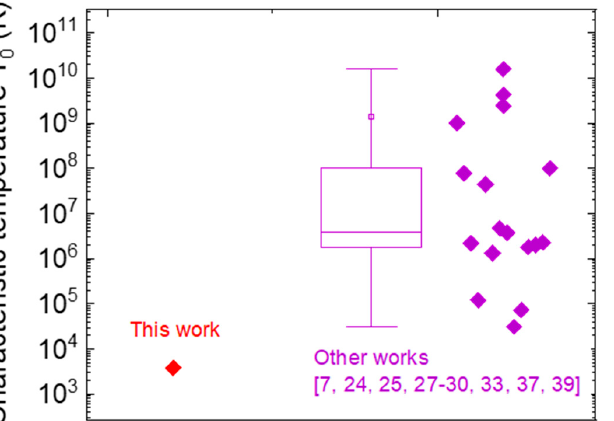
Figure 7. Comparison of the characteristic temperature (T 0 ) obtained from different works on GaN-based systems [7,24,25,27–30,33,37,39].